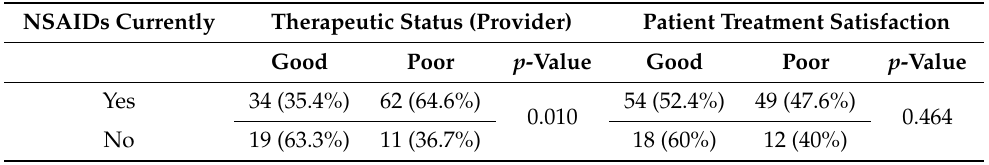
Table 3. The relationship between NSAID use and provider assessed therapy efficacy/patient- reported treatment satisfaction in the total patient